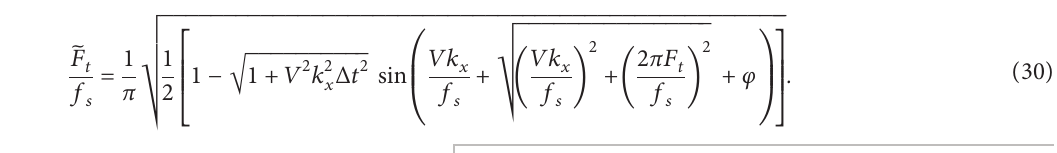
Figure 3: Imaginary and real parts of k [(a) and (b)] and ( k x ,k y ) � (40, 40) [(c) and